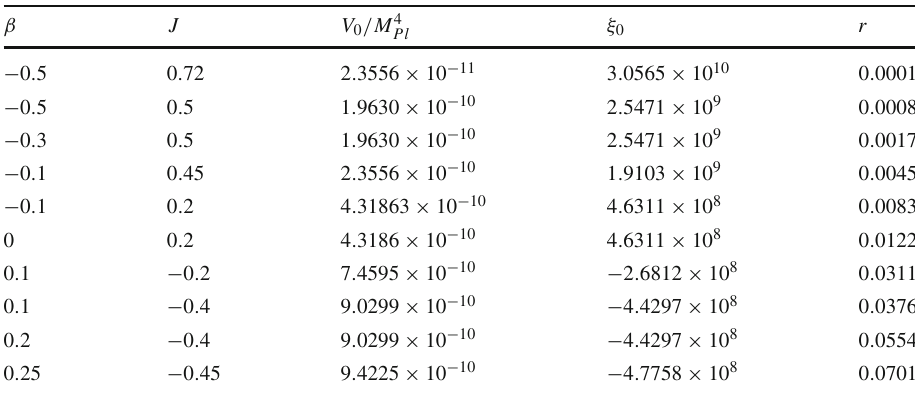
Table 1 Model parameters and the corresponding values of r for the exponential function F